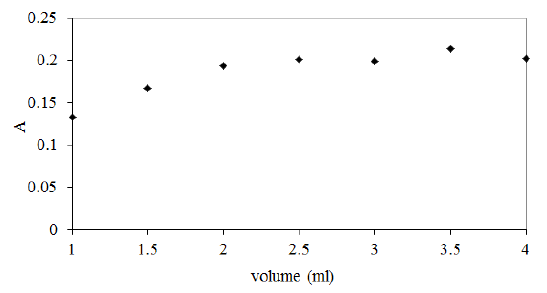
Figure 2. Influence of volume of the coloration agent on absorbance of Triton CF-21 solution (0.11 g L -1 ).